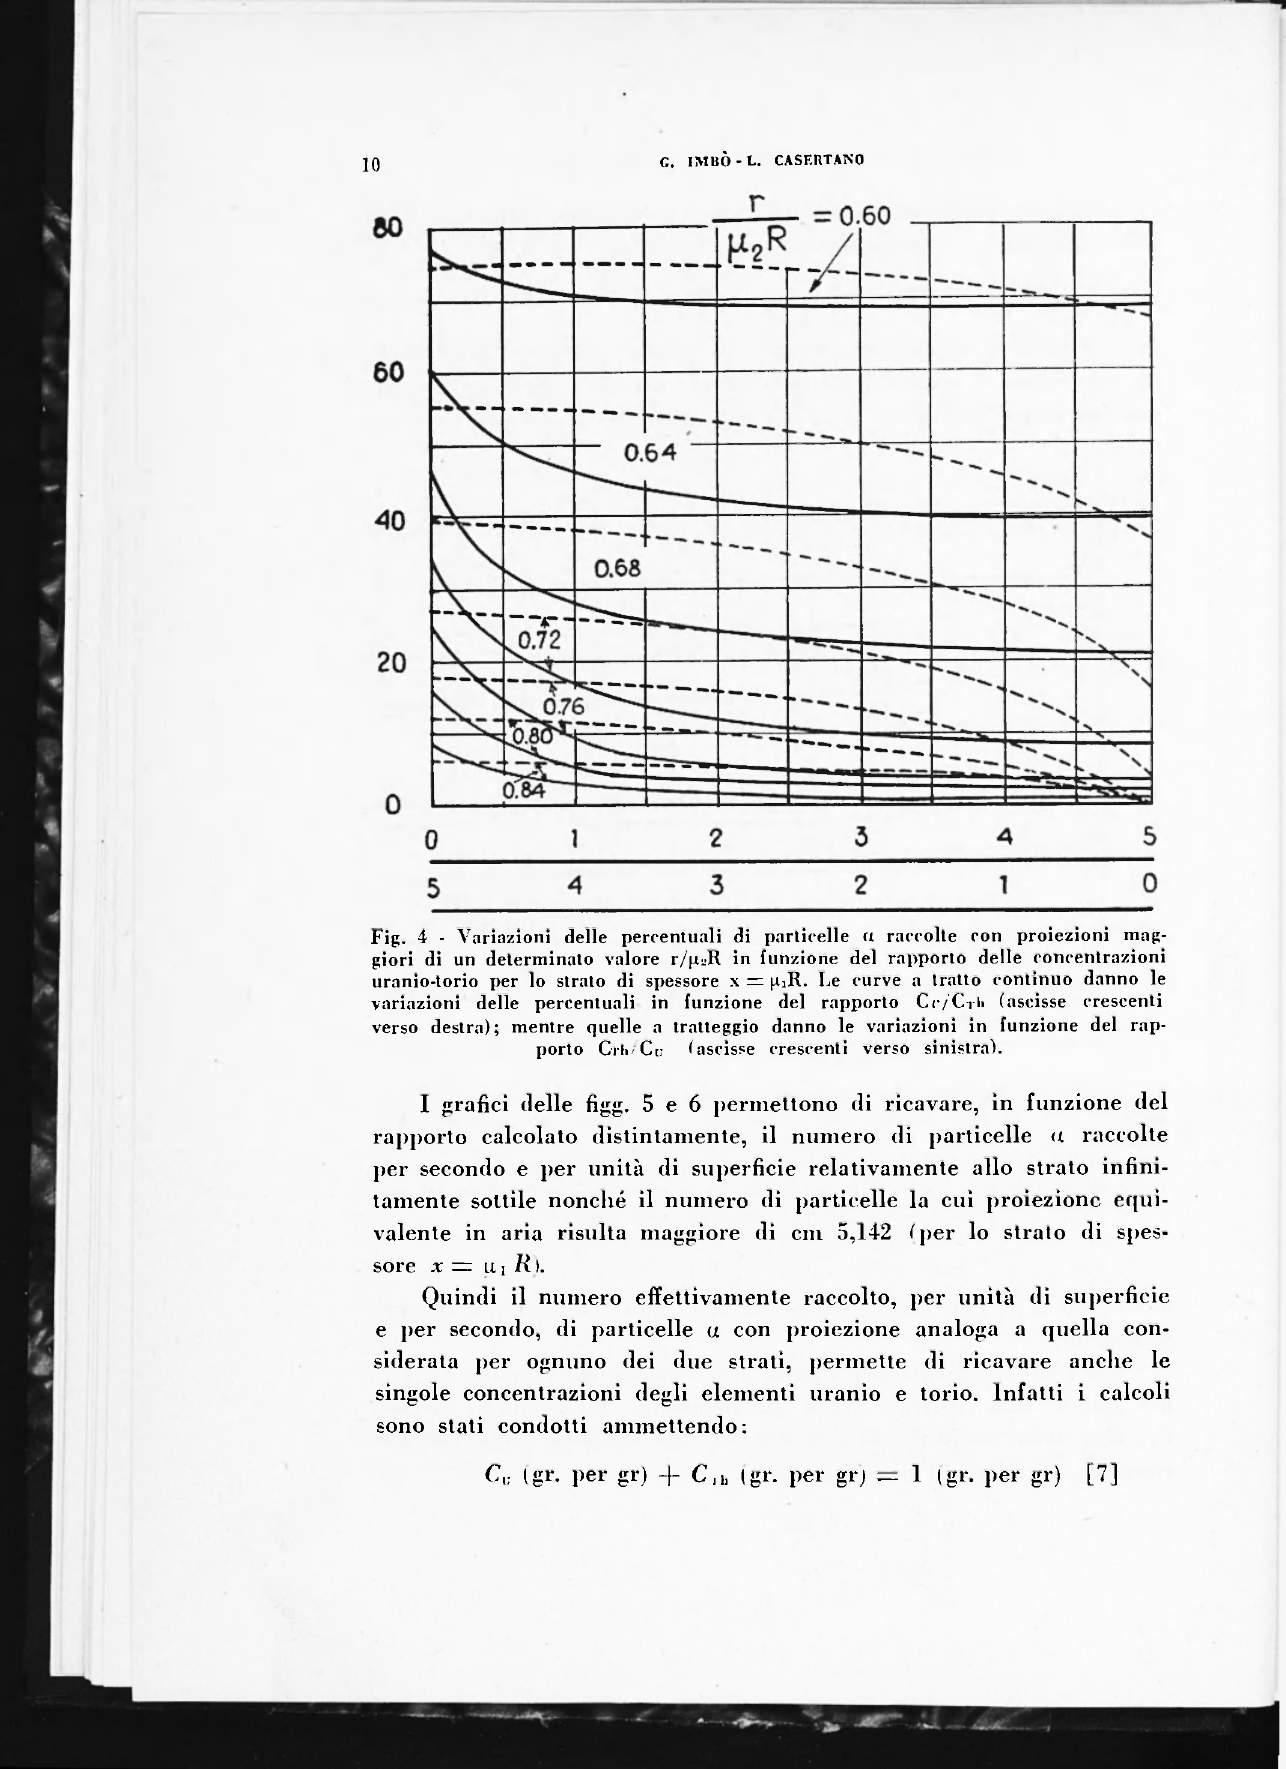
Fig. 4 - Variazioni delle percentuali di particelle u raccolte con proiezioni mag- giori di un determinato valore r/n^R in funzione del rapporto delle concentrazioni uranio-torio per lo strato di spessore x = |AIR. Le curve a tratto continuo danno le variazioni delle percentuali in funzione del rapporto Cc/'Crh (ascisse crescenti verso destra); mentre quelle a tratteggio danno le variazioni in funzione del rap- porto CTH/CC (ascisse crescenti verso sinistra). I grafici delle figg. 5 e 6 permettono di ricavare, in funzione del rapporto calcolato distintamente, il numero di particelle <( raccolte per secondo e per unità di superficie relativamente allo strato infini- tamente sottile nonché il numero di particelle la cui proiezione equi- valente in aria risulta maggiore di cm 5,142 (per lo strato di spes- sore x = ui